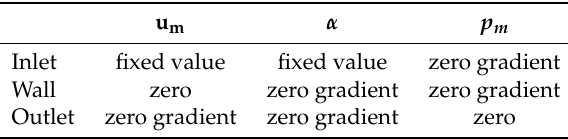
Table 1. Primal boundary